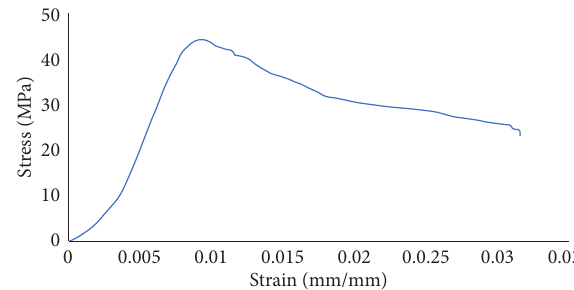
Figure 7: Compressive stress-strain curve of the specimen.